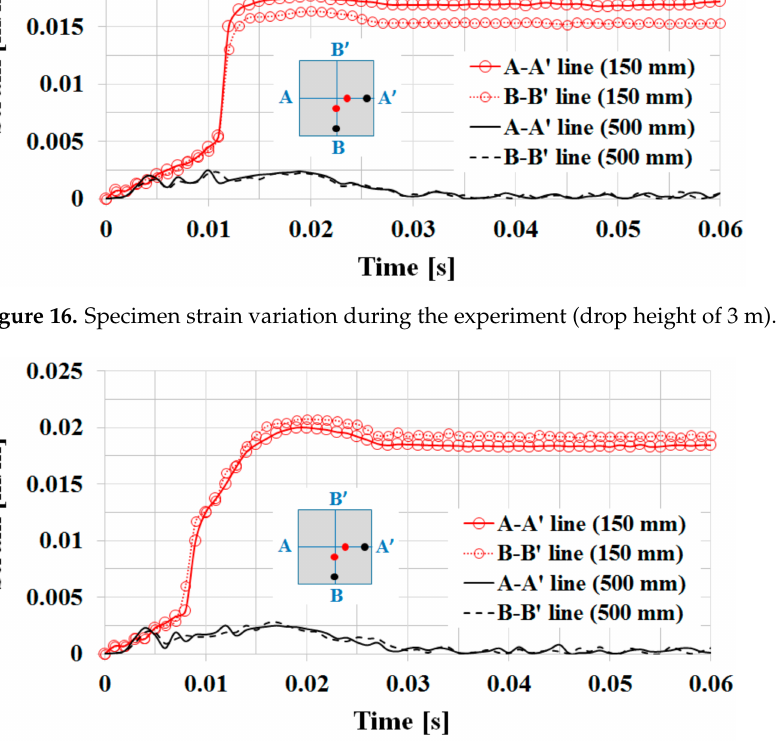
Figure 17. Specimen strain variation during the experiment (drop height of 5 m).